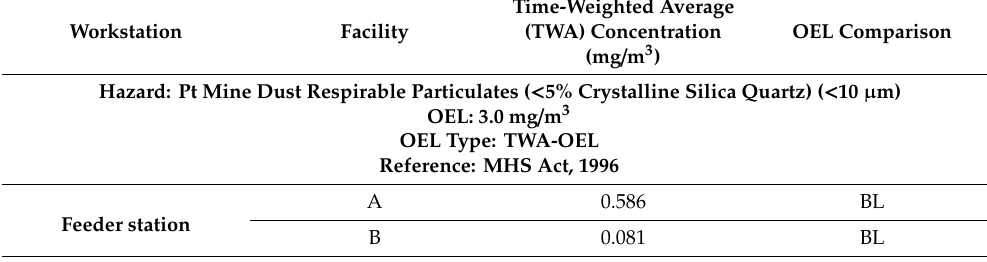
Table 3. Workstations’ Pt mine dust respirable particulate in comparison with the TWA OELs.